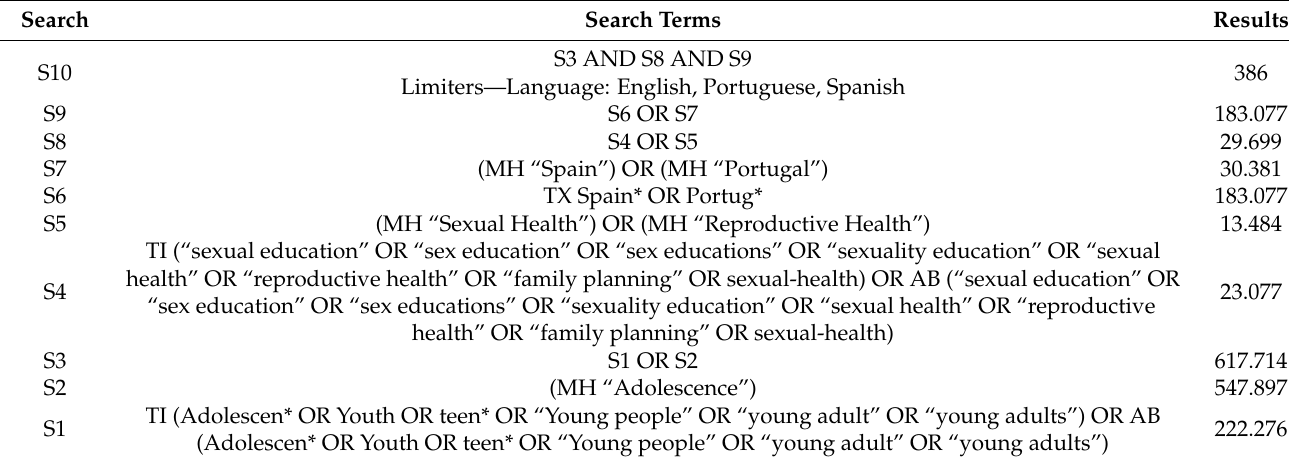
Table A1. Search at Cinhal Complete via EBSCO in 6 April